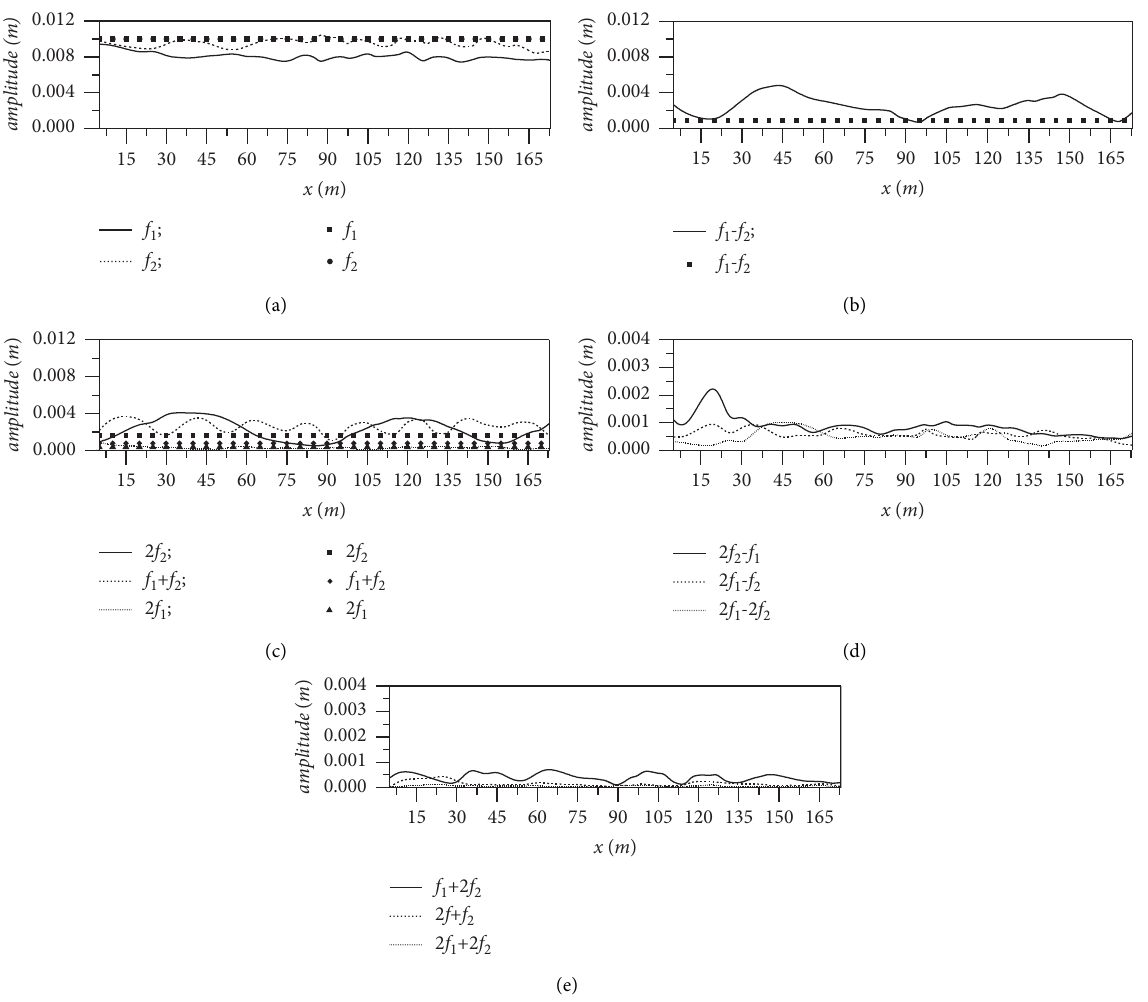
Figure 5: Comparisons of the spatial variation of amplitudes of each frequency component between calculation and theoretical results for case